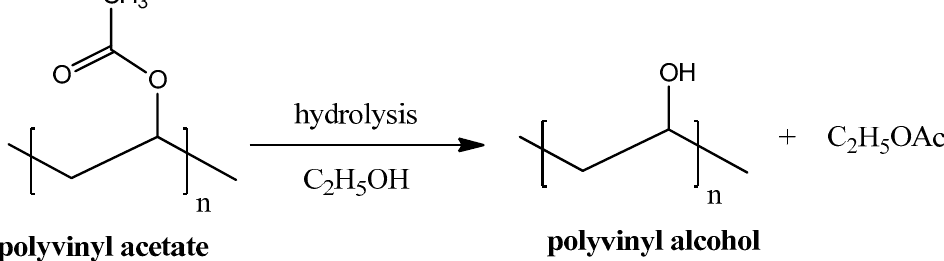
Figure 7. Polyvinyl alcohol synthesis from polyvinyl acetate hydrolysis.